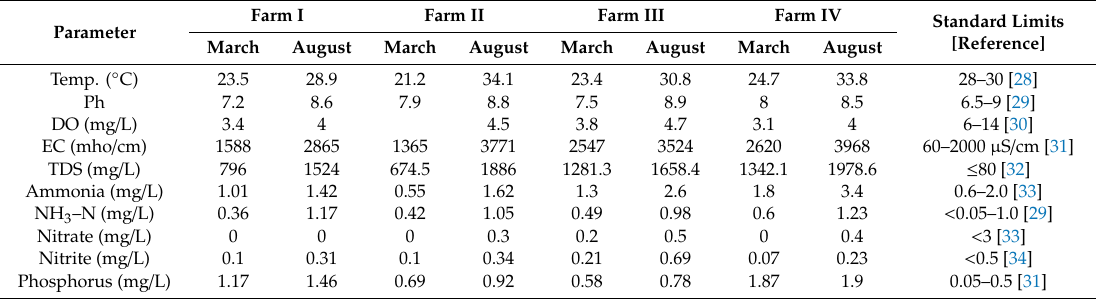
Table 3. Physicochemical water parameters of the examined farms at the beginning and at the end of study (March and August 2017).